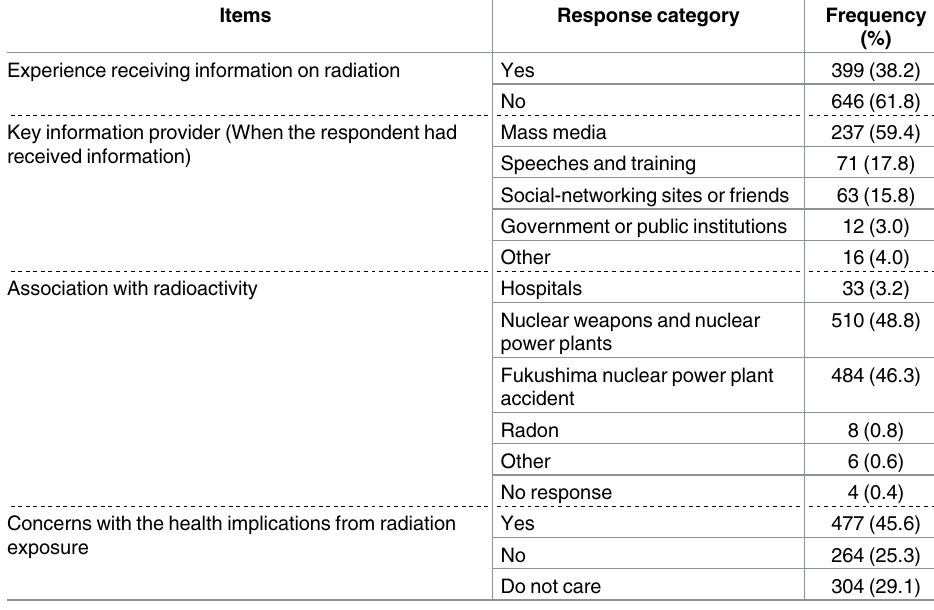
Table 2. Participants’ channels of information acquisition and perceptions on